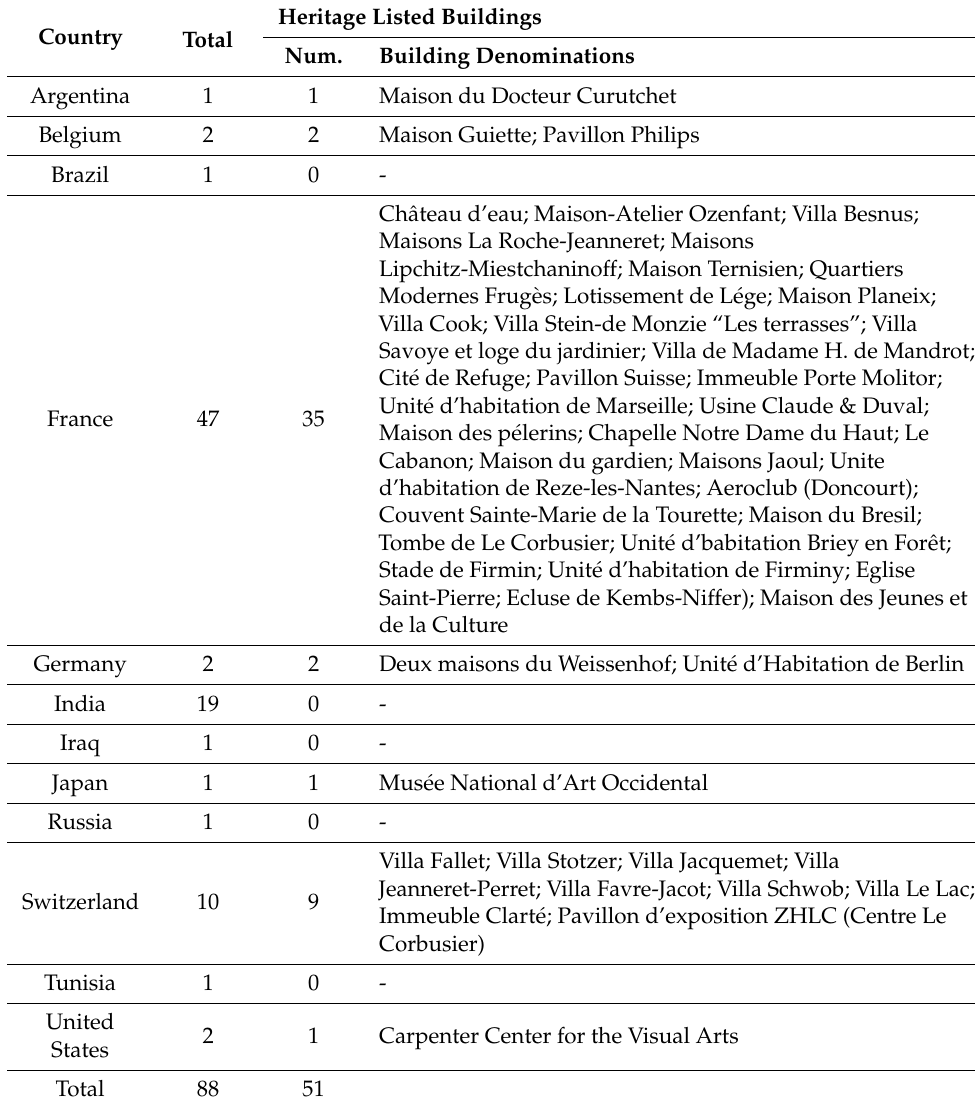
Table 1. Total number of construction sites and buildings that have been heritage listed by